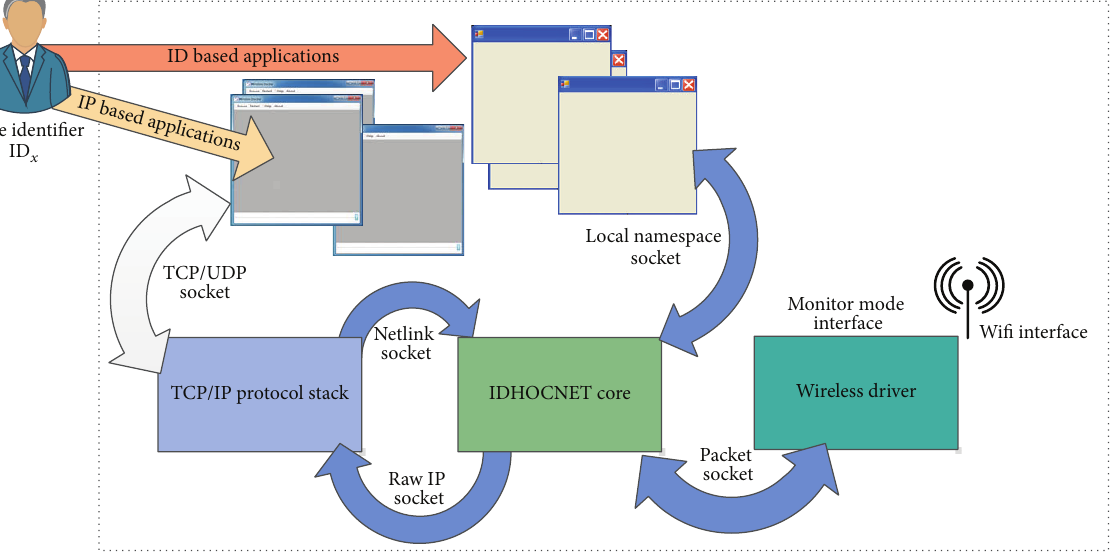
Figure 12: Placement of IDHOCNET in operating system.